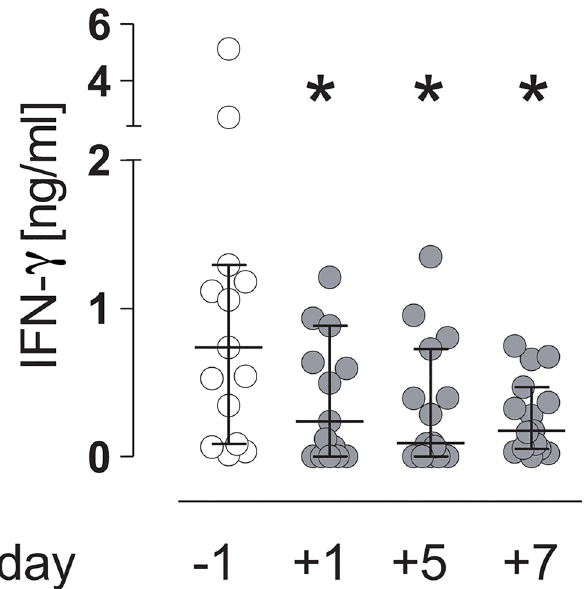
Fig 1. Visceral surgery interferes with the responsiveness to Staphylococcus aureus . Peripheral blood from “ patients 1 ” was drawn 1 d before (-1) and 1 d (+1), 5 d (+5), and 7 d (+7) after surgery. PBMC were isolated and stimulated with inactivated S . aureus . The amount of IFN- γ in the supernatant was quantified. Results are expressed as scatter plot (median, interquartile range). Statistical differences were tested using the Wilcoxon signed rank test. n = 20; * , p < 0.05 vs. day